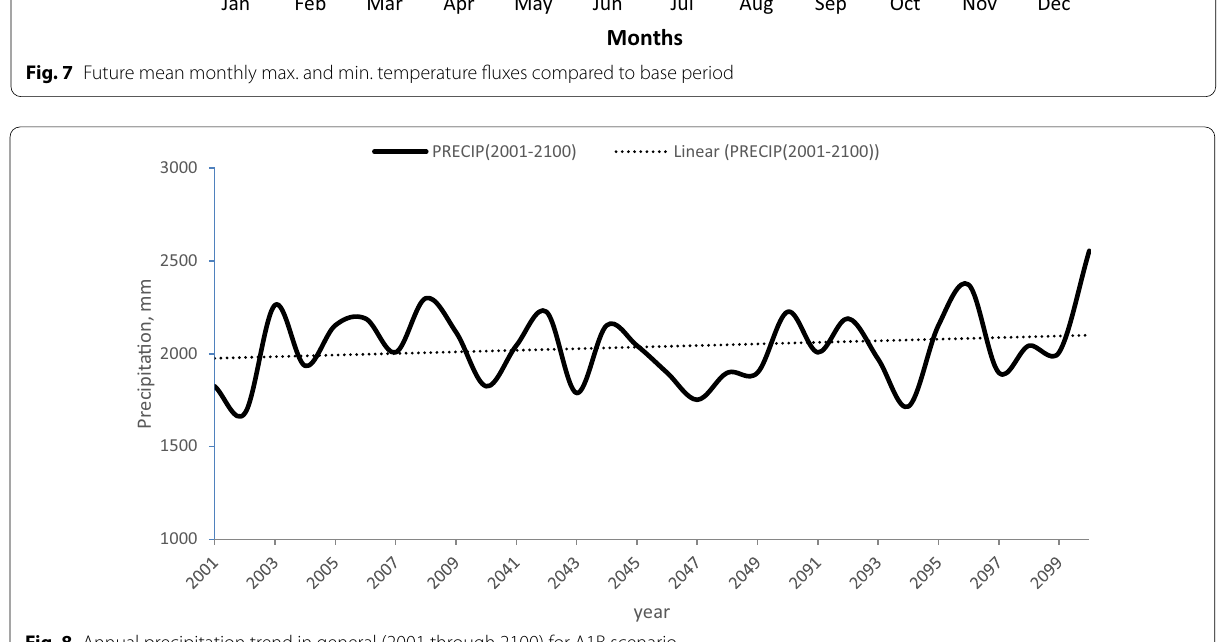
Fig. 8 Annual precipitation trend in general (2001 through 2100) for A1B